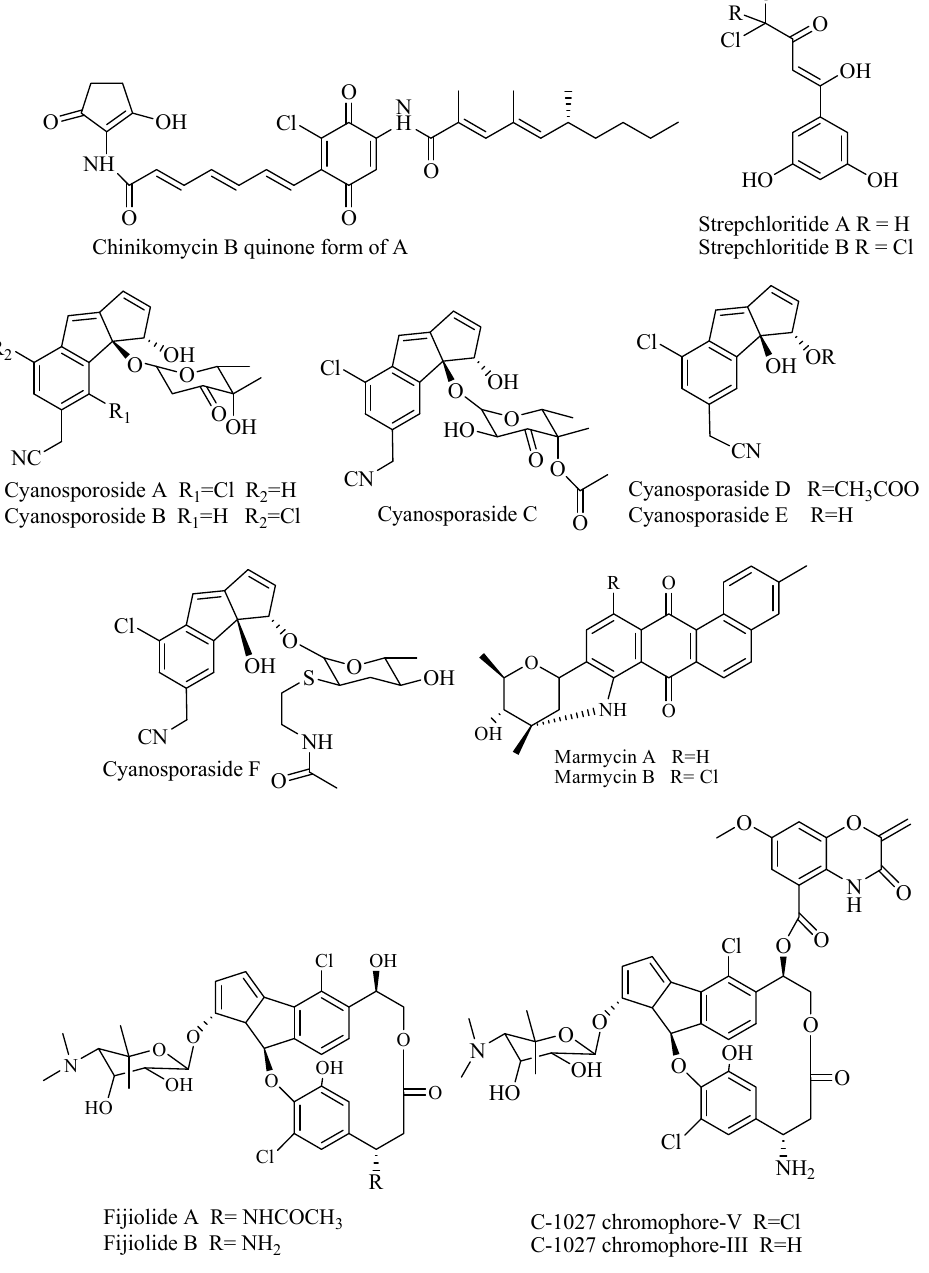
Figure 5. Halogenated polyketide.